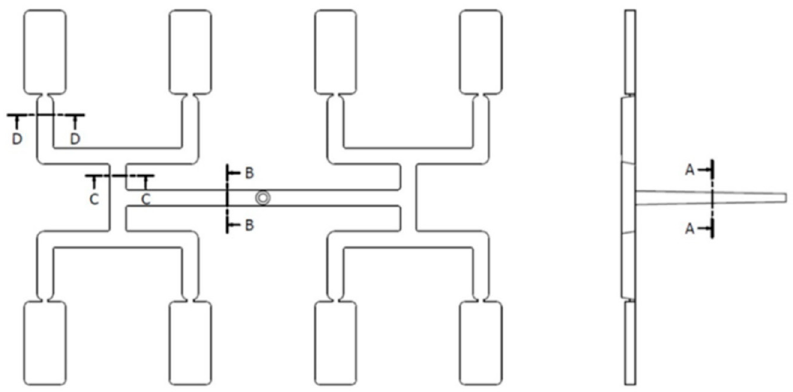
Figure 13. Specific cross-sections of the runner system.